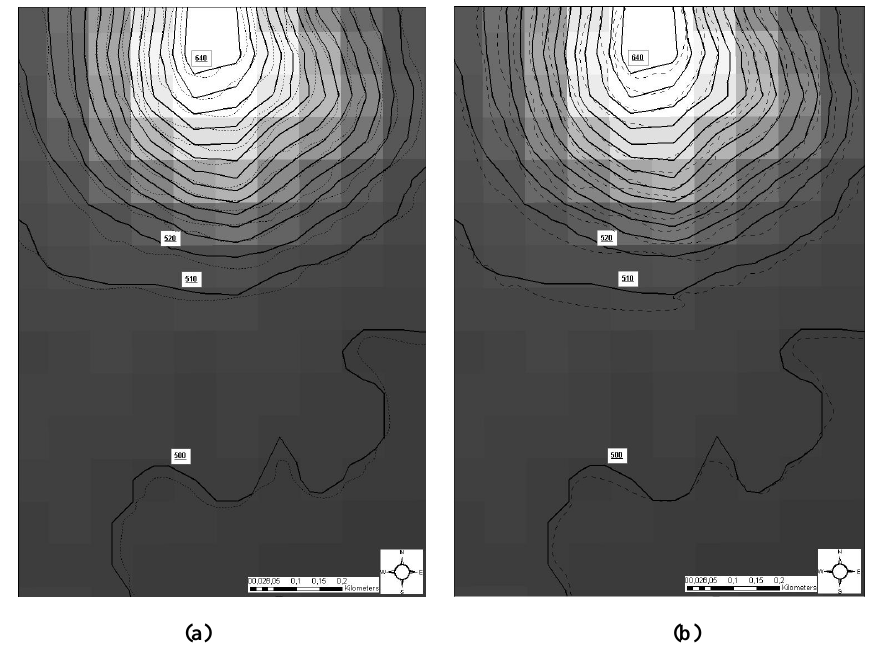
Figure 4 Elevation differences between SRTM DEM (solid line) and ASTER (dotted line) (a) ASTER March 2006 and (b) ASTER December 2006; all contour lines are superimposed over a hillshade of the SRTM. The scenes mark a subset with a mix of moderate to high topography representing the worst case scenario of DEM errors.